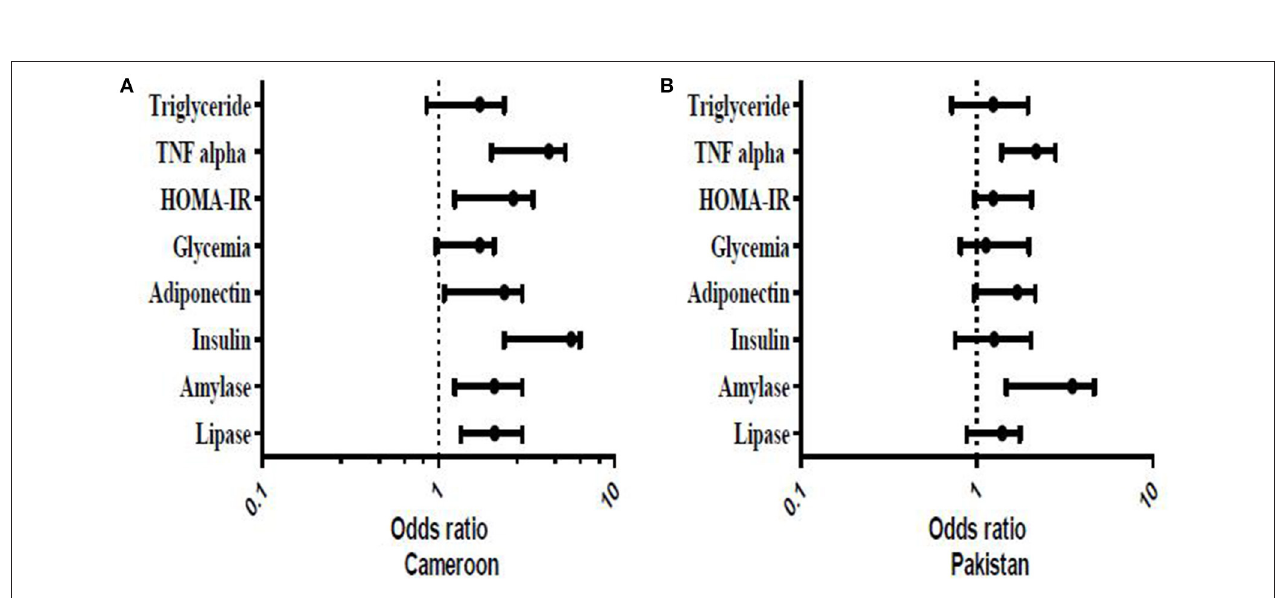
FIGURE 5 | Representation of Binomial Logistic Regression of endocrine and exocrine pancreatic functions tests according of exposure. The model was adjusted (0: exposed individuals; 1: for unexposed individuals). The results were significant if P ≤ 0.05.